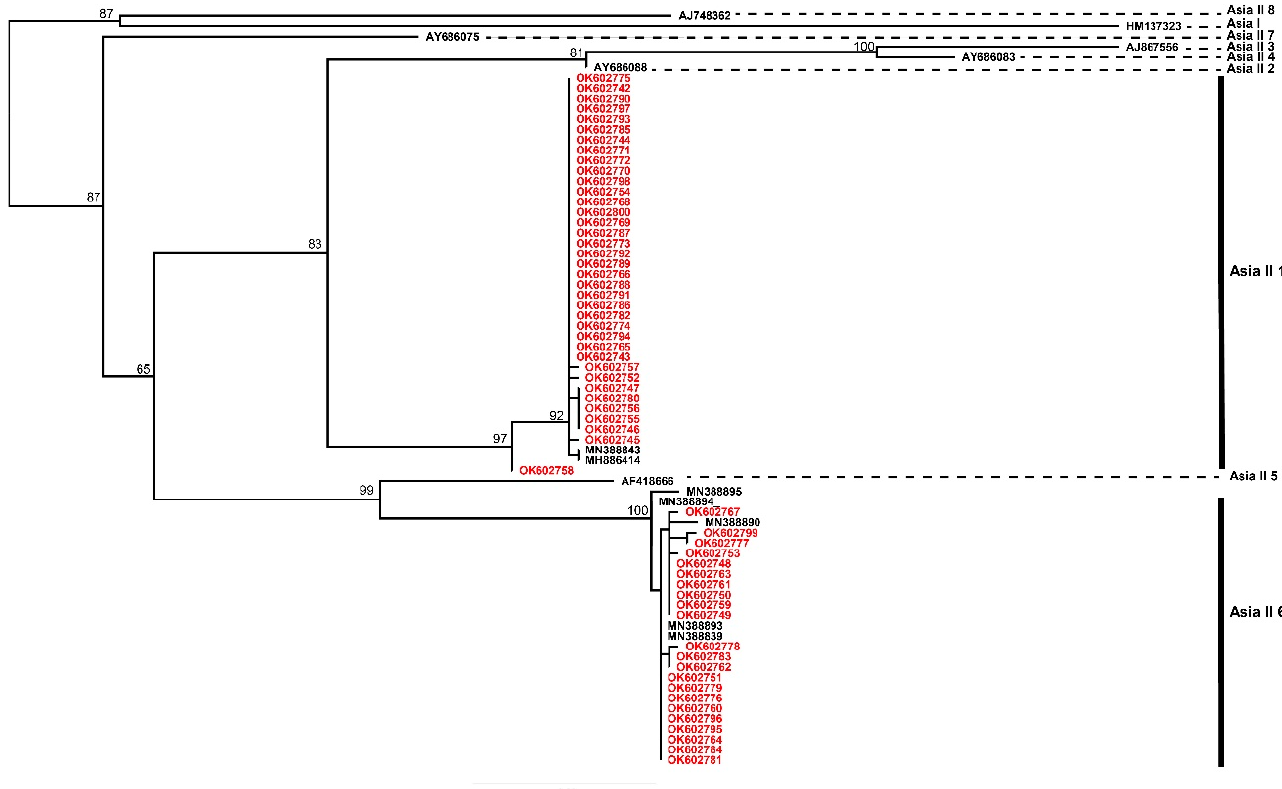
Figure 4. Maximum Likelihood phylogenetic analysis of all consensus sequences from the region. mtCOI using IQTree with 1000 bootstrap replications involving 669 nt of sequences obtained in this study (in red) and reference sequences from whiteflies occurring in Asia. Detailed information on the sequences used in this analysis are included in Table S1.